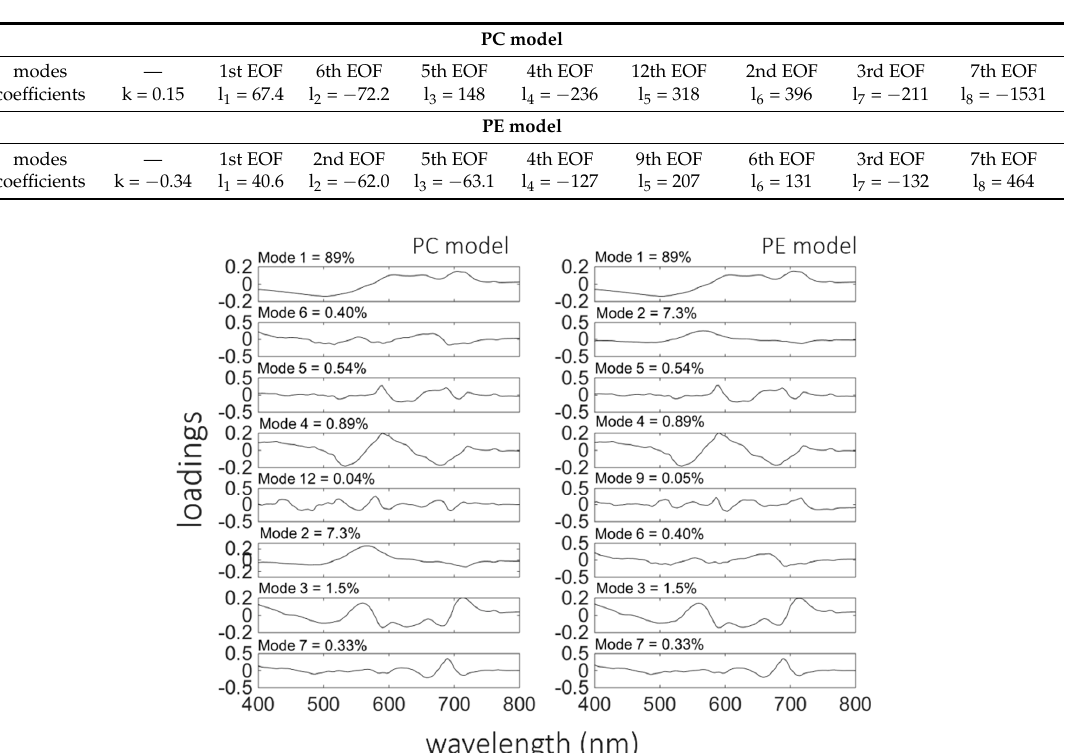
Table 6. Selected EOF modes and regression coefficients (4) of phycocyanin (PC) and phycoerythrin (PE) models.